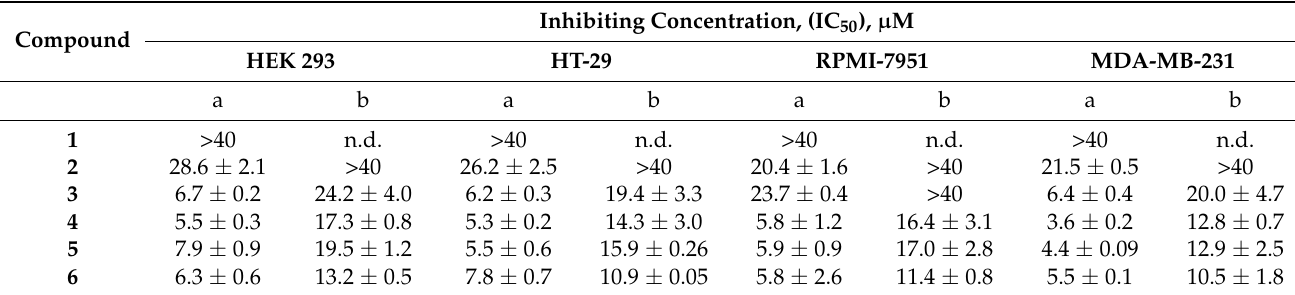
Table 3. Cytotoxic activities of compounds 1 – 6 and their mixtures with cholesterol. Values are indicated as mean ± standard